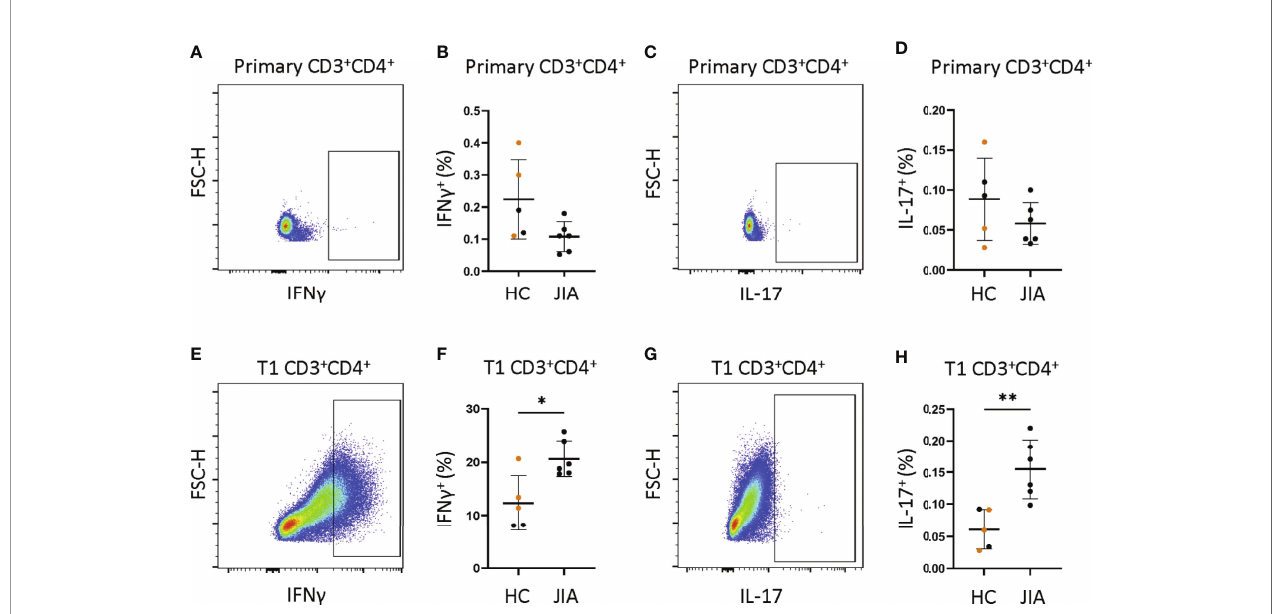
FIGURE 5 | JIA naïve CD4 + cells become IFN g and IL-17 producers under T1 polarizing conditions. Naïve CD4 + cells JIA (n=6) and HC (n=3 adult (orange) and 2 child healthy controls (black)) were analyzed by fl ow cytometry for production of IFN g and IL-17 in primary cells and T1 polarized cells. (A) Representative fl ow cytometry plot from JIA primary naïve CD4 + cells showing IFN g positive cells. (B) Primary naïve CD4 + cells frequency of IFN g positive cells in HC and JIA. (C) Representative fl ow cytometry plot from JIA primary naïve CD4 + cells showing IL-17 positive cells. (D) Primary naïve CD4 + cells frequency of IL-17 positive cells in HC and JIA. (E) Representative fl ow cytometry plot from JIA T1 polarized naïve CD4 + cells showing IFN g positive cells. (F) T1 polarized naïve CD4 + cells frequency of IFN g positive cells in HC and JIA. (G) Representative fl ow cytometry plot from JIA T1 polarized naïve CD4 + cells showing IL-17 positive cells. (H) T1 polarized naïve CD4 + cells frequency of IL-17 positive cells in HC and JIA. Shown is mean with standard deviation. Analysis by Welch ’ s t-test with *p<0.05,